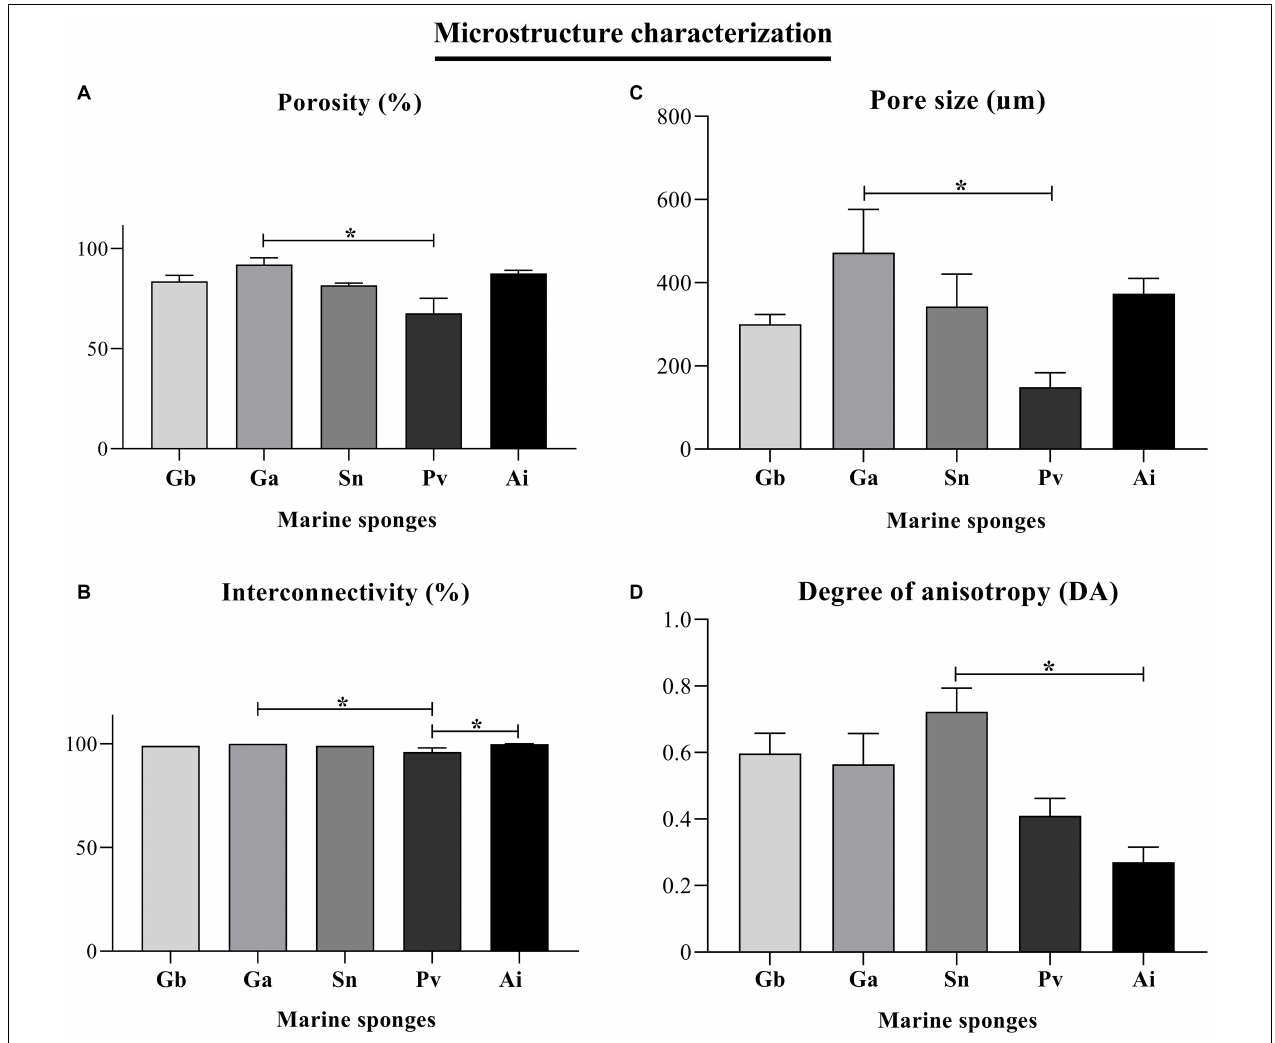
FIGURE 8 | Morphometric parameters of the 3D microstructure of the Geodia barretti (Gb), Geodia atlantica (Ga), Stelletta normani (Sn), Phakellia ventilabrum (Pv), and Axinella infundibuliformis (Ai). Micro-CT results for porosity (%) (A) , interconnectivity (%) (B) , pore size ( µ m) (C) , and degree of anisotropy (DA) (D) . Data expressed as mean ± SD with three replicates per sponge species and the asterisks (*) indicate statistically significant differences ( p < 0.05) after Kruskal–Wallis test with Dunn’s multiple